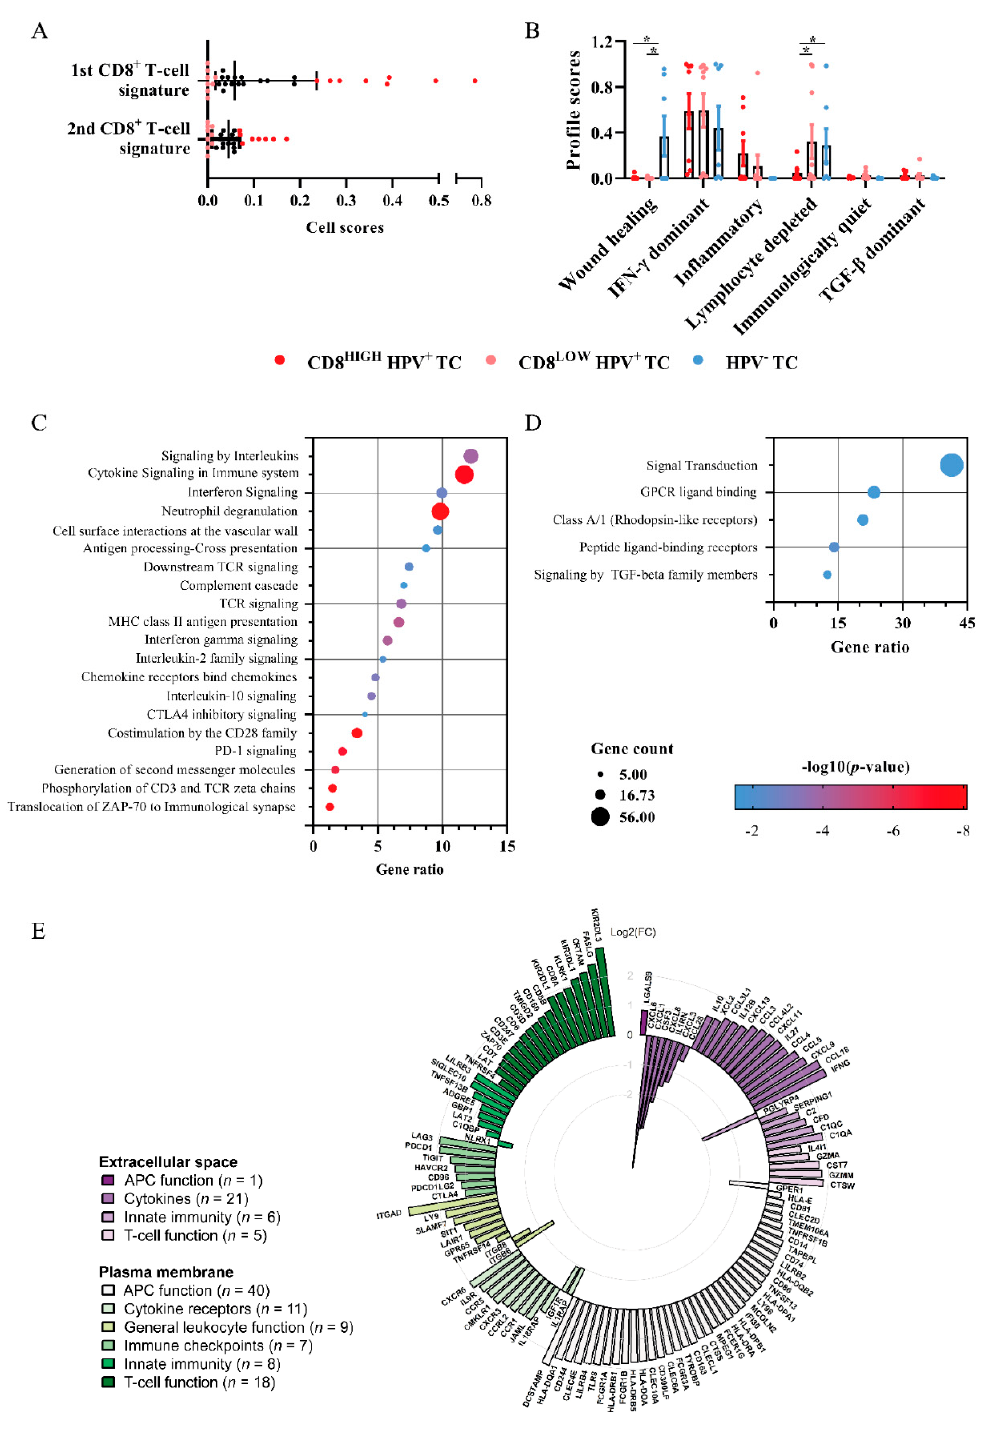
Figure 4. Transcriptomic analysis of whole tissue RNAseq TC datasets from TCGA. ( A ) Scatter plots showing the division of HPV + TC samples based on cell signatures into CD8 HIGH and CD8 LOW HPV + TC [18,19]. ( B ) Profile scores of the groups based on six TCGA immune signature profiles [17]. ( C,D ) Bubble plot displaying REACTOME pathway enrichment in CD8 HIGH HPV + and CD8 LOW HPV + TC, respectively. Each bubble represents the gene ratios, defined as the ratio of genes in the pathway divided by the total genes obtained. The size corresponds to the number of obtained genes in a pathway and the color with –LOG10 p -value. ( E ) Sunburst circos plots showing 126 DEG between CD8 HIGH and CD8 LOW HPV + TC, associated with extracellular space and plasma membrane. The immune-related genes are distributed according to the FC values. Differentially expressed genes (DEGs); fold change (FC); The Cancer Genome Atlas (TCGA). Adjusted p -values are shown as * < 0.05.